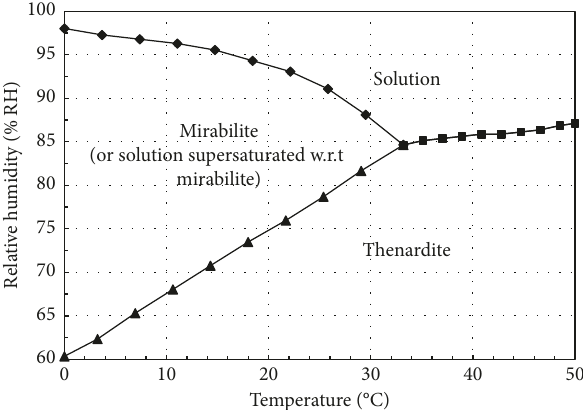
Figure 1: Phase diagrams for sodium sulfate